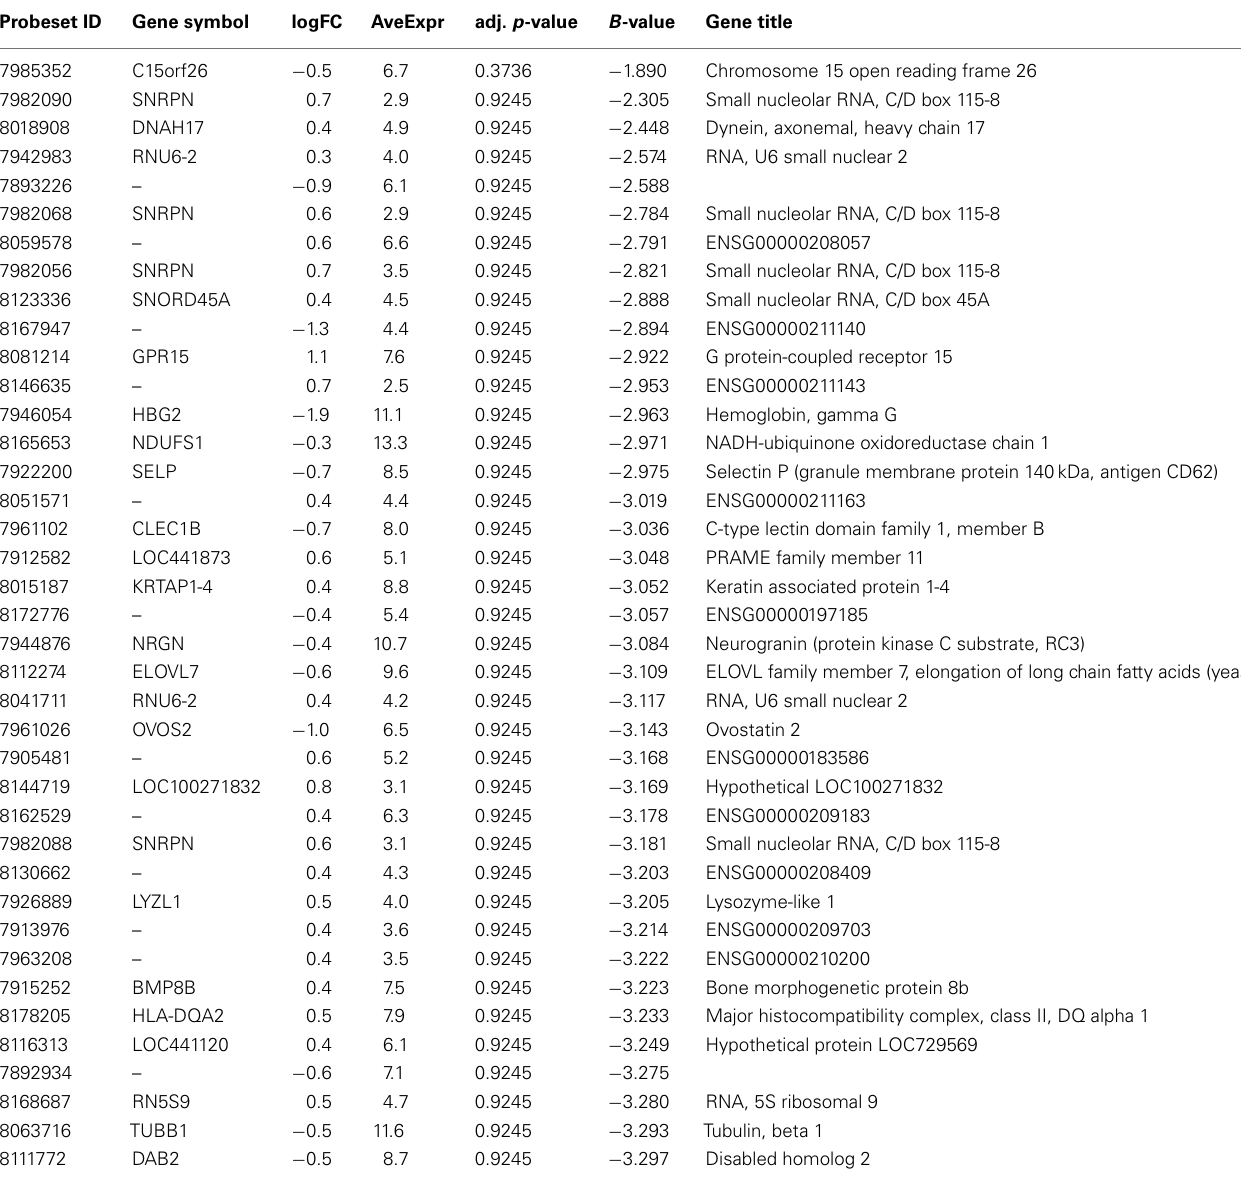
TableA1 | Expression analysis of the blood RNA between HIV negative drug users and the healthy control group. Probeset